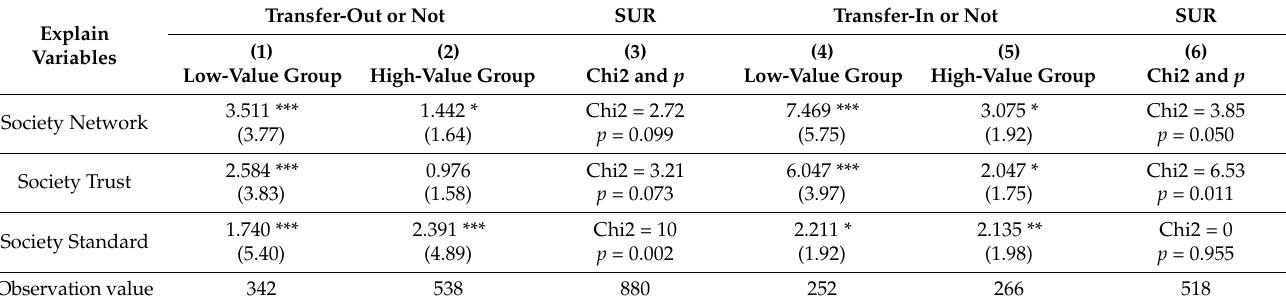
Table 7. Tests for differences in coefficients between groups based on the seemingly unrelated